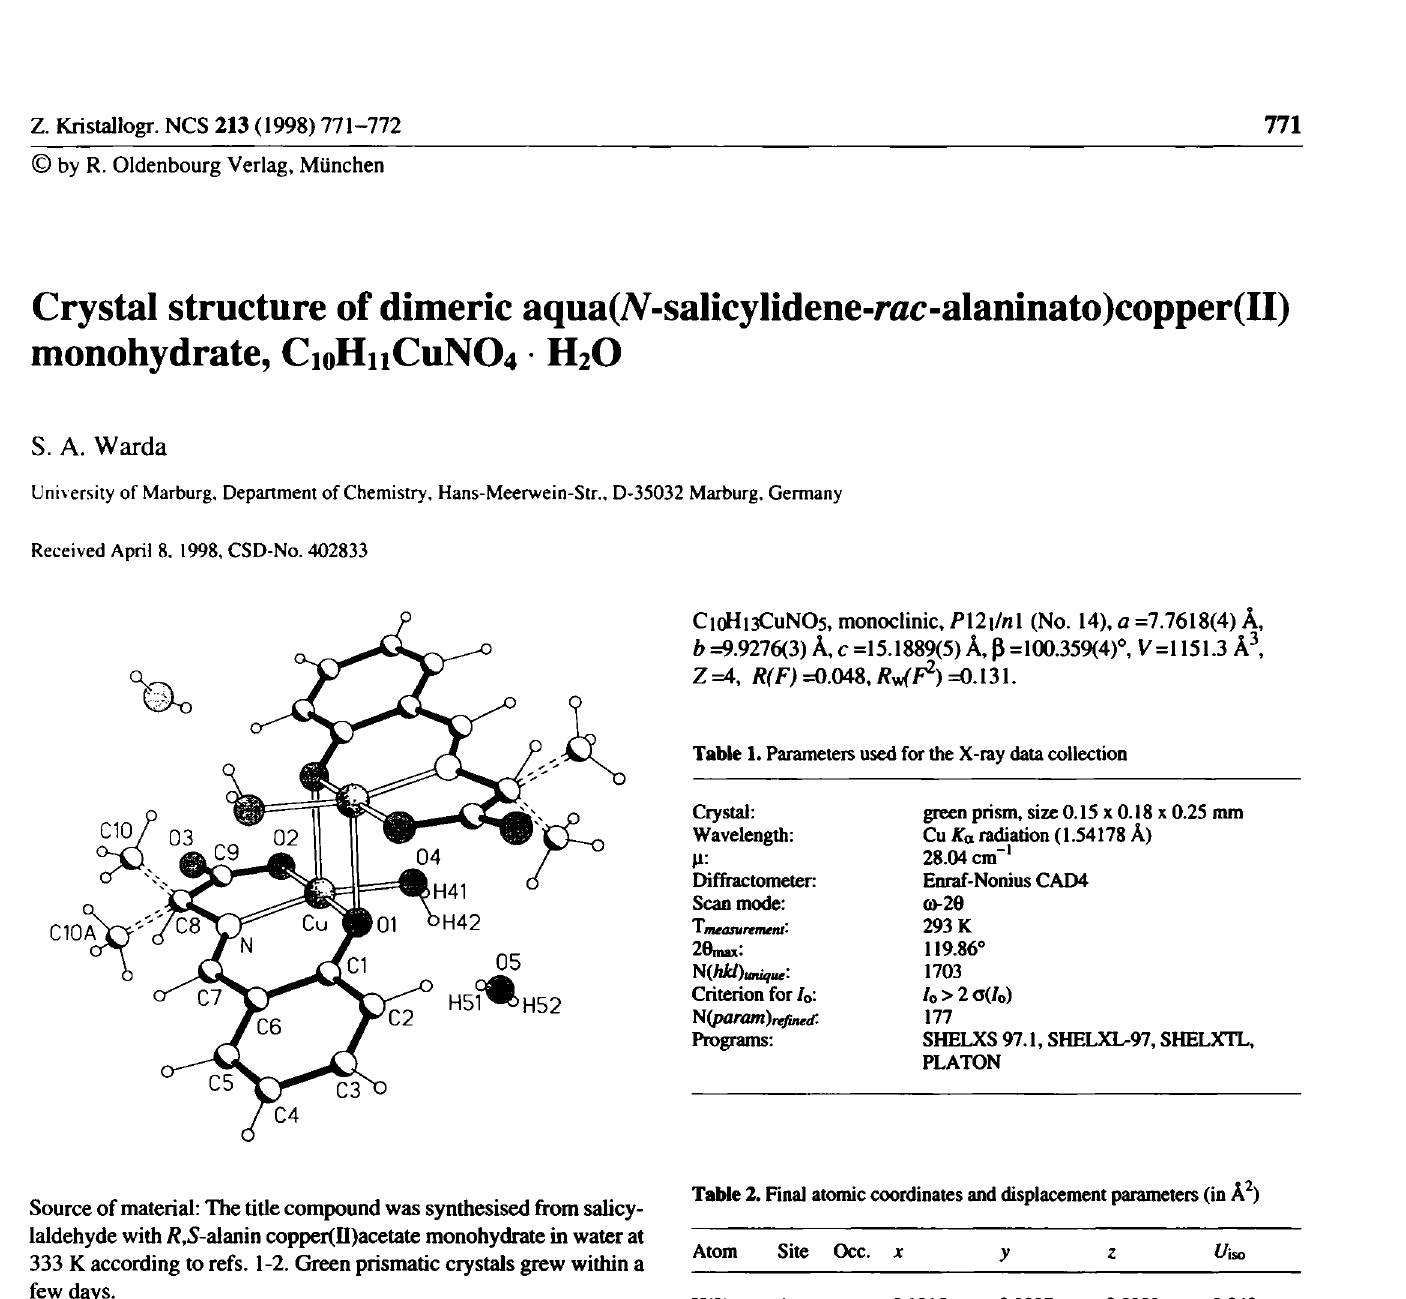
Table 2. Final atomic coordinates and displacement paiameteis (in